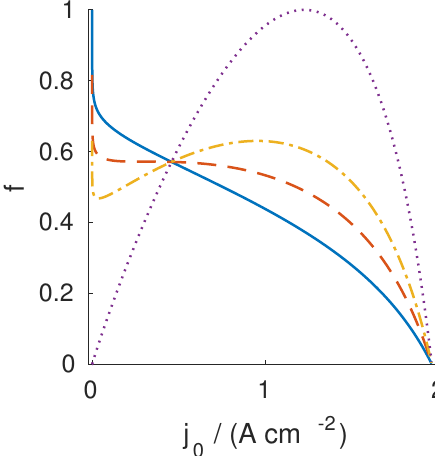
Figure 4. Objective function of power vs. efficiency optimization for 4 different weights. Dotted: w P = 1, dash-dotted: w P = 0.37, dashed: w P = 0.18, solid w P =